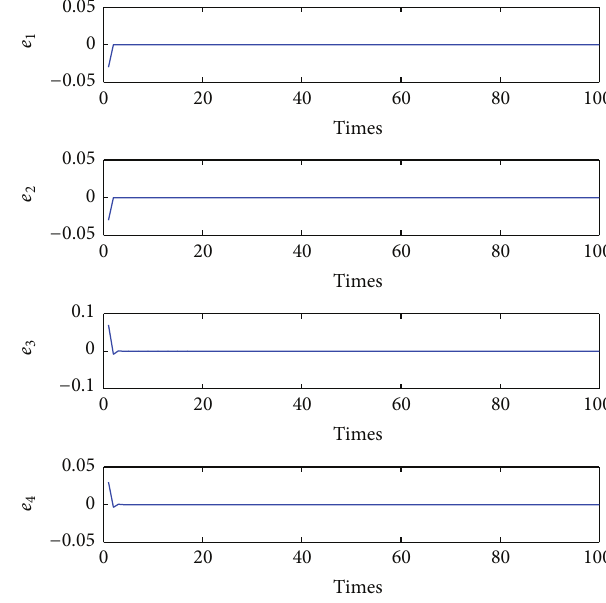
Figure 12: Synchronization errors 𝑒 1 , 𝑒 2 , 𝑒 3 ,𝑒 4 of 𝑛 > 𝑚 . 𝑎 > 0 , 𝑎 > 0 , and 𝑎 > 0 , and 𝑃 is a positive 2 3 4